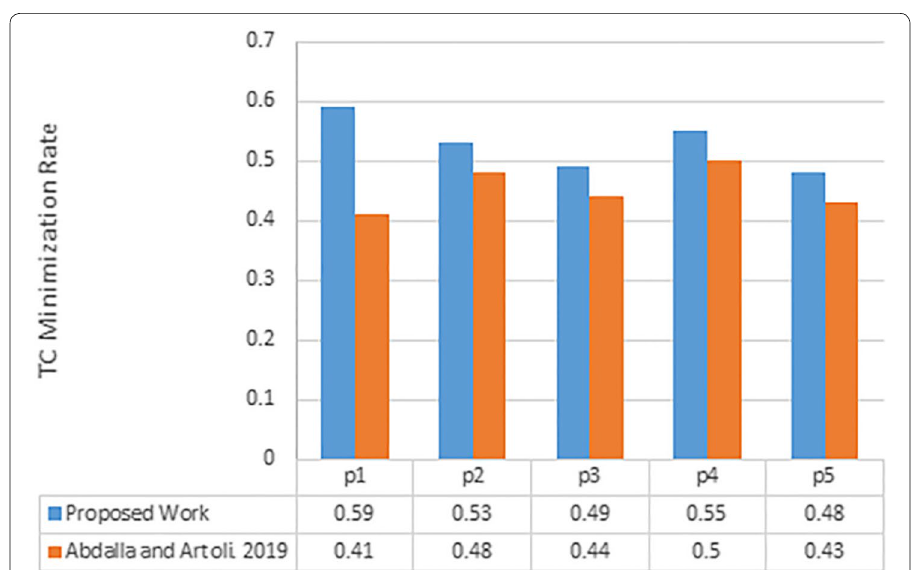
Fig. 10 Scenario 4—TC minimization in percentage: take the average TC over all problems